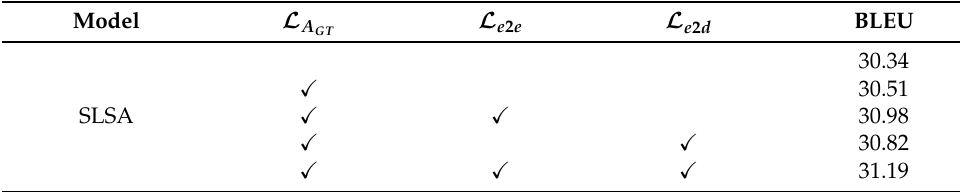
Table 3. The effectiveness of each loss on DE → EN validation set.